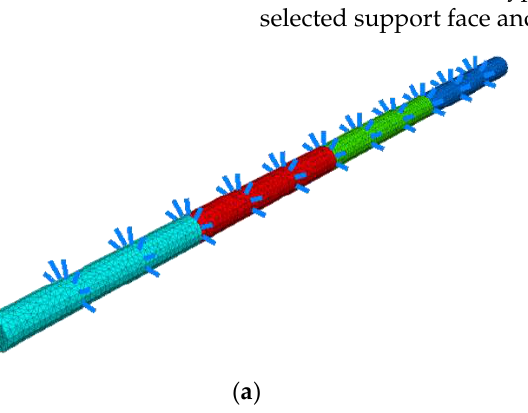
Figure 4. Schematic diagram of the analysis unit of the tunnel: ( a ) supported tunnel and ( b ) analysis unit and two analysis face.